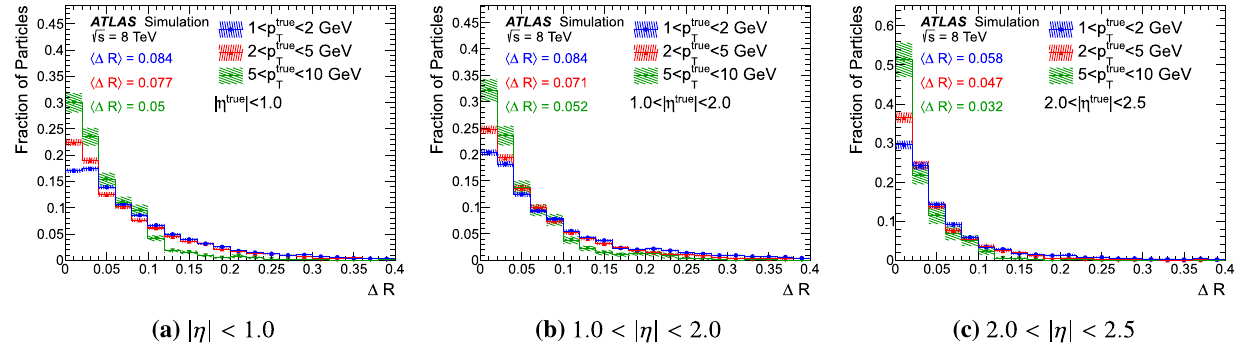
Fig. 13 The cone size (cid:8) R around the extrapolated track required to encompassboththeleadingandsub-leadingtopo-clusters,for π ± when < 70% of their true deposited energy in topo-clusters is contained in the leading topo-cluster, but > 90% of the energy is contained in the two